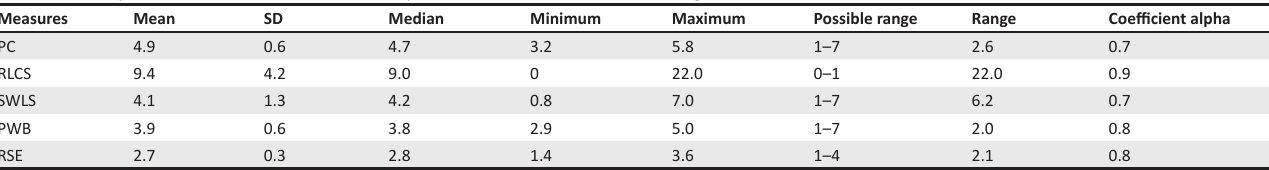
TABLE 2: Descriptive statistics and internal consistency reliabilities for control and well-being measures. Measures